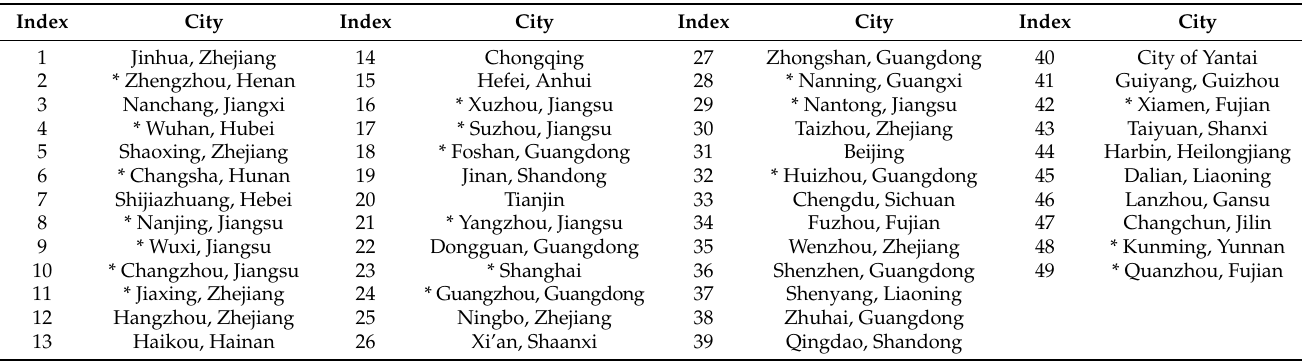
Table 2. AH rankings of first-tier, new first-tier, and second-tier